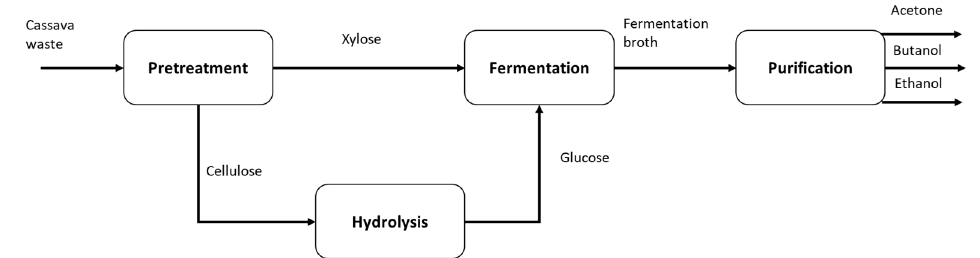
Figure 1. Hierarchized layout for butanol production.